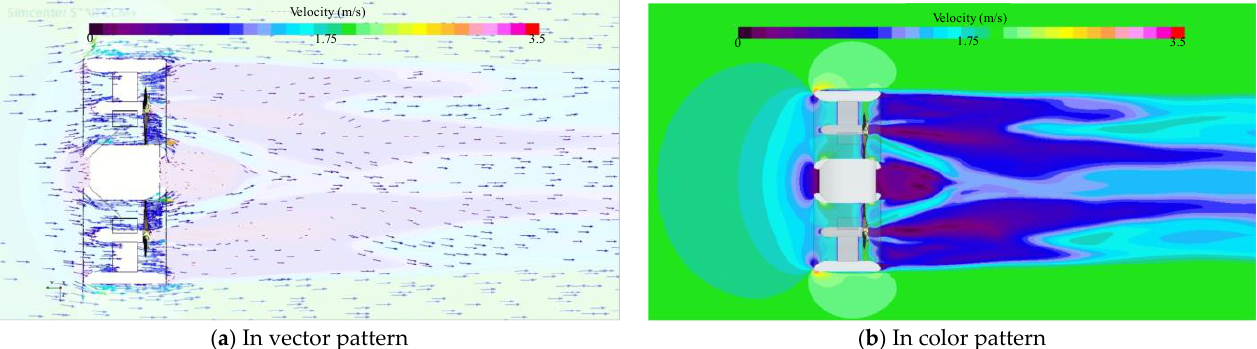
Figure 8. Velocity field around turbine ( V = 2 m/s, TSR = 3.5).